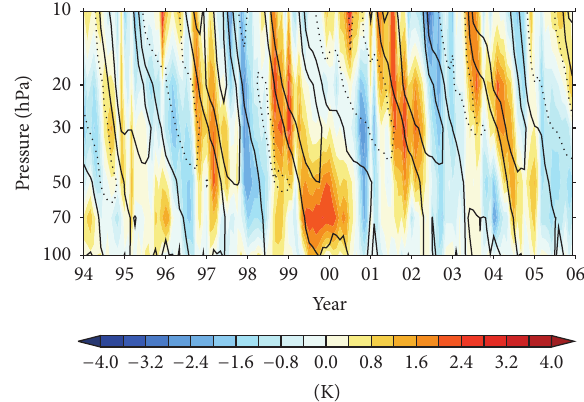
Figure 10: Time-pressure cross sections of temperature (colors) and zonal wind (contour levels) anomalies from 1994 to 2005. The contour interval of zonal wind is 10 m/s, and the value range is from − 40 m/s to 40 m/s. The temperature anomalies are calculated here by removing the seasonal cycle. The zonal anomalies are calculated here by removing the time averaged zonal wind from 1994 to